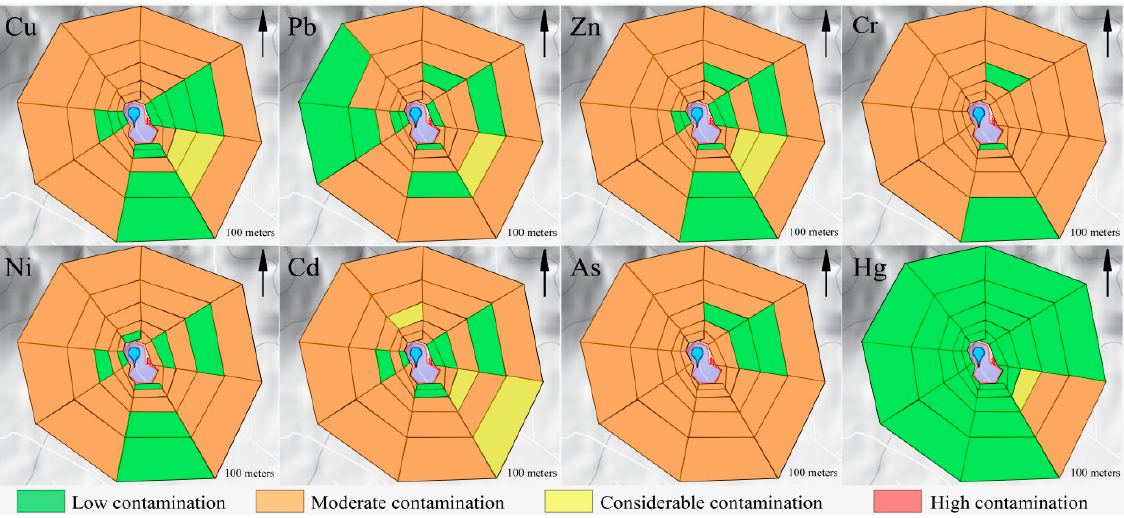
Figure 4. Distribution of soil heavy metal pollution characteristics.